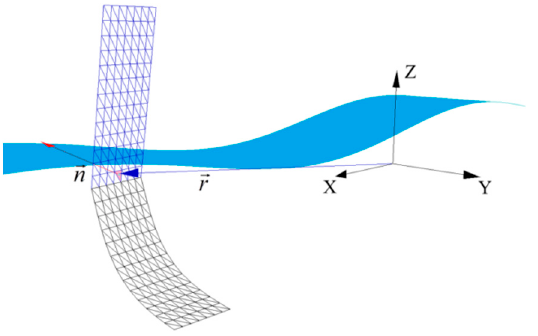
Figure 2. Calculation of triangular panel submergence.